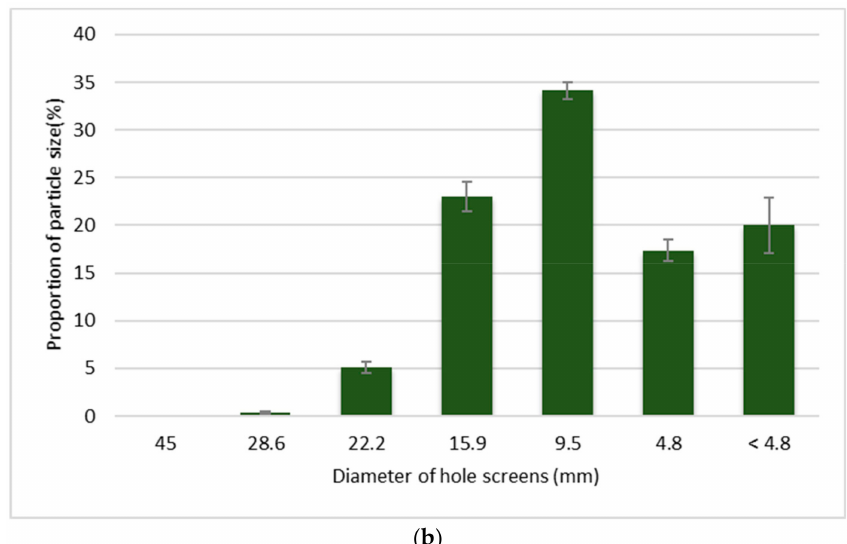
Figure 3. ( a ) Average proportion of shavings and sawdust by sieve opening sizes with their associated standard deviations. ( b ) Mean proportion of wood chips by hole screens size diameters with their associated standard deviations. Table 1. Fuel quality related parameters (mean ± standard deviation) of the four residue sources. Values represent averages of four samples. d.b. = dry basis, w.b. = wet basis. Dry Solid Wood Engineered Green Wood Parameter Shavings Sawdust Wood Sawdust Chips Moisture content (%, d.b.) Moisture content (%,